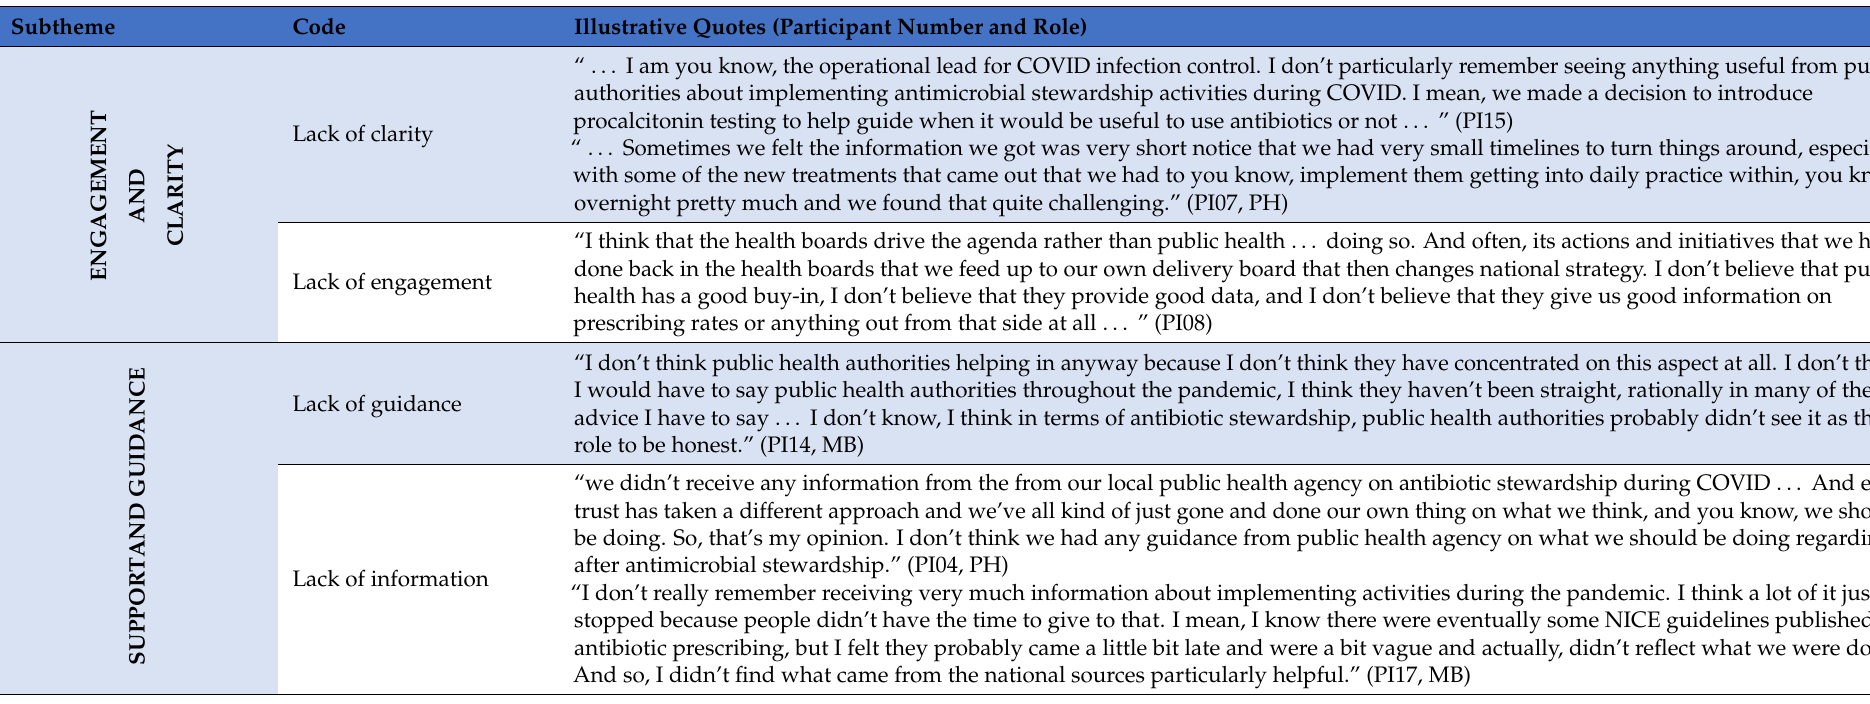
Table 4. THEME THREE: Information from public authorities on AMS during